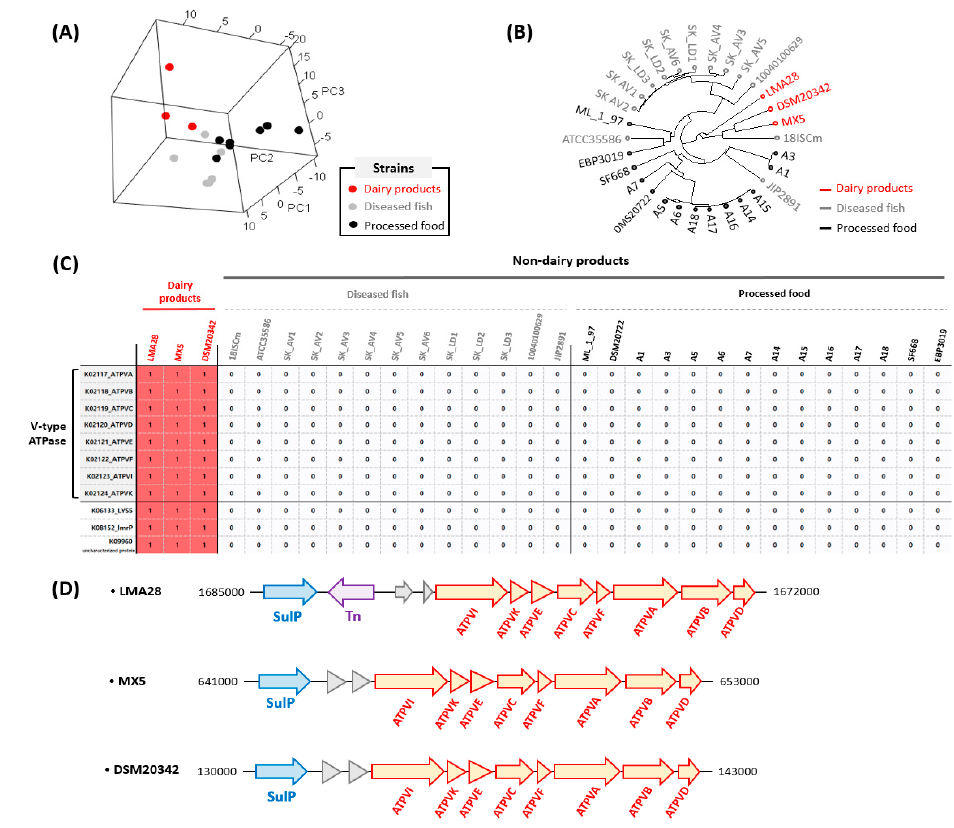
Figure 1. Three-dimensional principal component analysis (PCA) of strains derived from dairy products, diseased fish, and processed food based on the profiling of KEGG Ontology (ko) genes ( A ). Clustering of 30 strains of Carnobacterium maltaromaticum isolated under different conditions ( B ). The accessory genes and ko_id that shared only dairy strains among 30 strains of C. maltaromaticum ( C ). The serial array of sulfate permease (SulP), transposase (Tn), and the components of V-type ATPase (ATPVA, ATPVB, ATPVC, ATPVD, ATPVE, ATPVF, ATPVI, and ATPVK) in the dairy strains of chromosomal DNA ( D